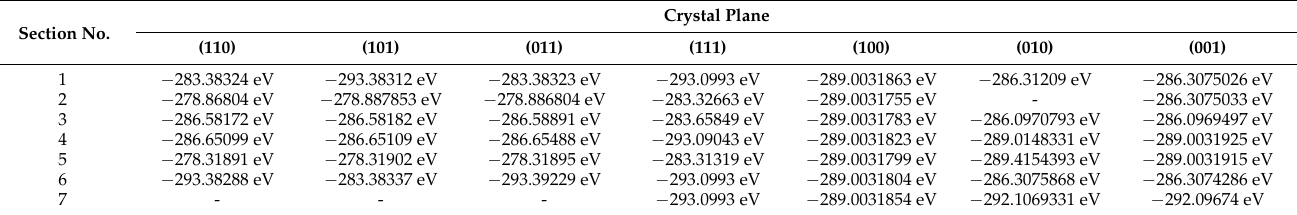
Table 2. Energy calculation of different Al 2 O 3